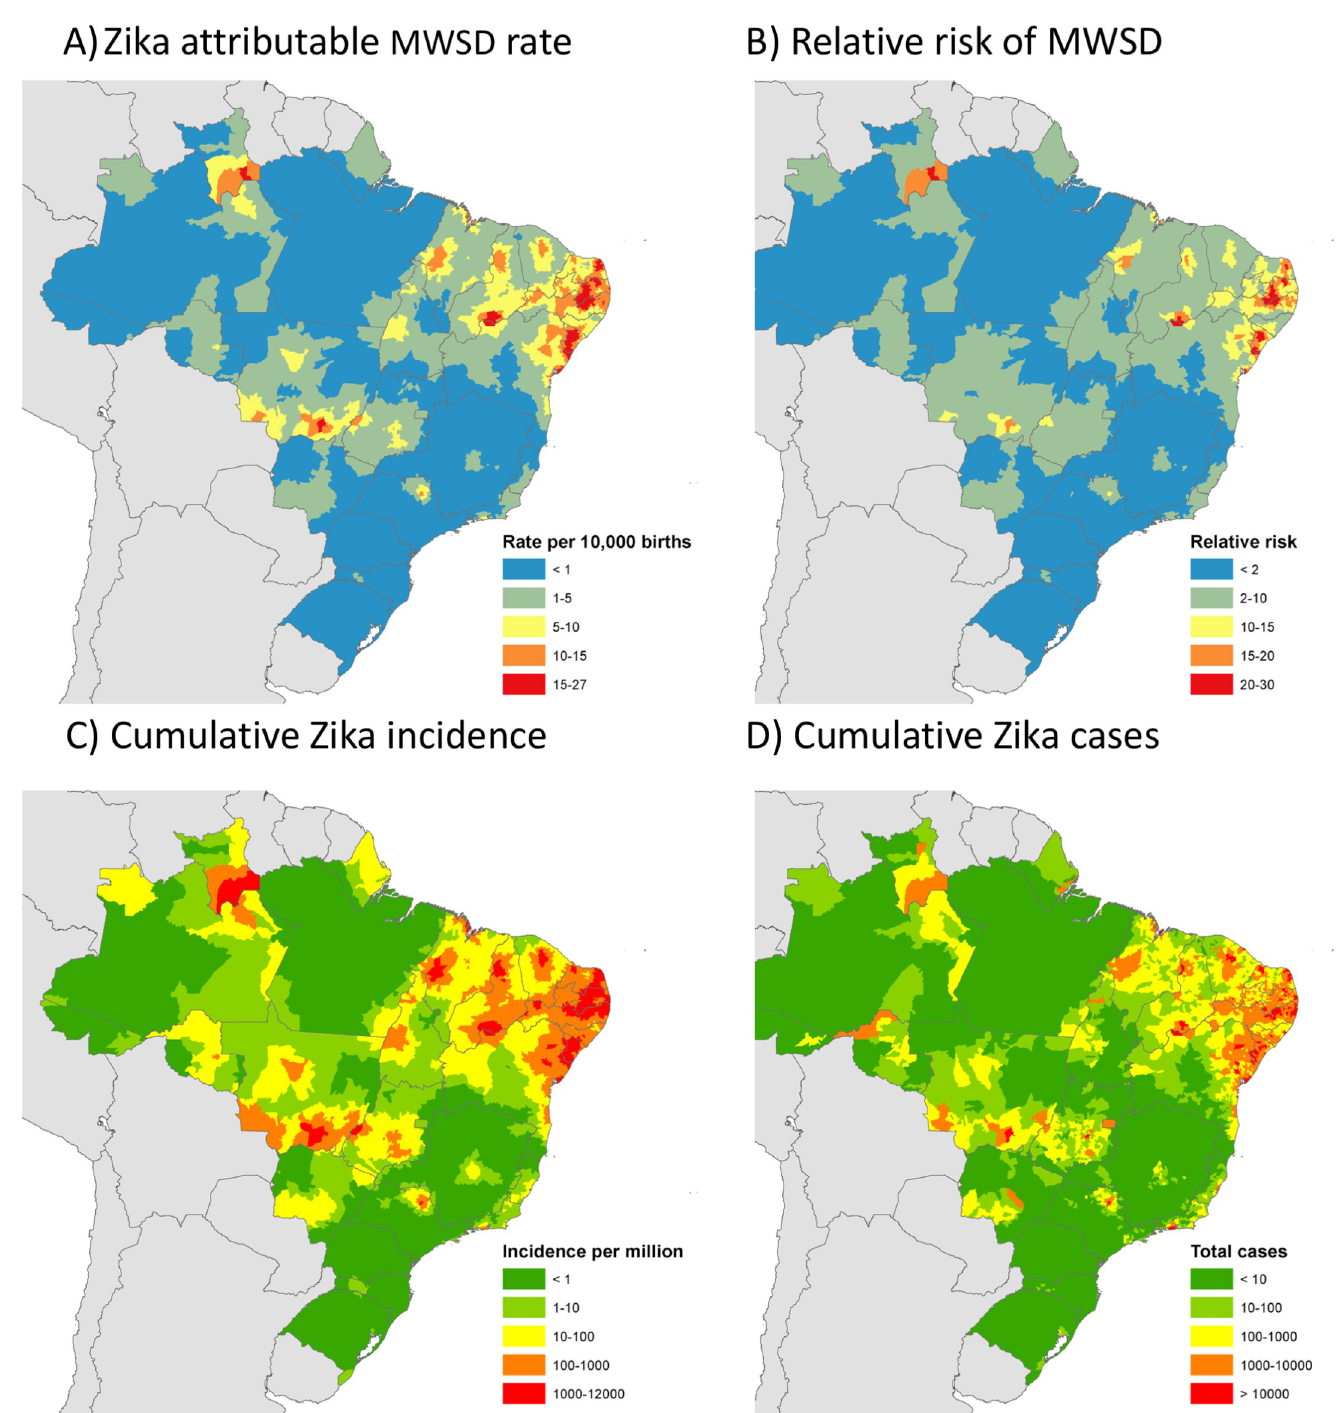
Fig 4. Concentration of the Zika virus (ZIKV) outbreak in Northeast Brazil. This figure shows (A) the ZIKV-attributable absolute rate of microcephaly with structural brain defects (MWSD) per 10,000 live births, (B) the relative risk of MWSD at birth given the ZIKV outbreak experienced in each municipality, (C) the model-predicted cumulative symptomatic Zika case incidence on a log 10 scale, and (D) the model-predicted total cumulative symptomatic Zika cases on a log 10 scale. All maps show municipality-level predictions averaged or summed over the time period January 2015–May 2017.